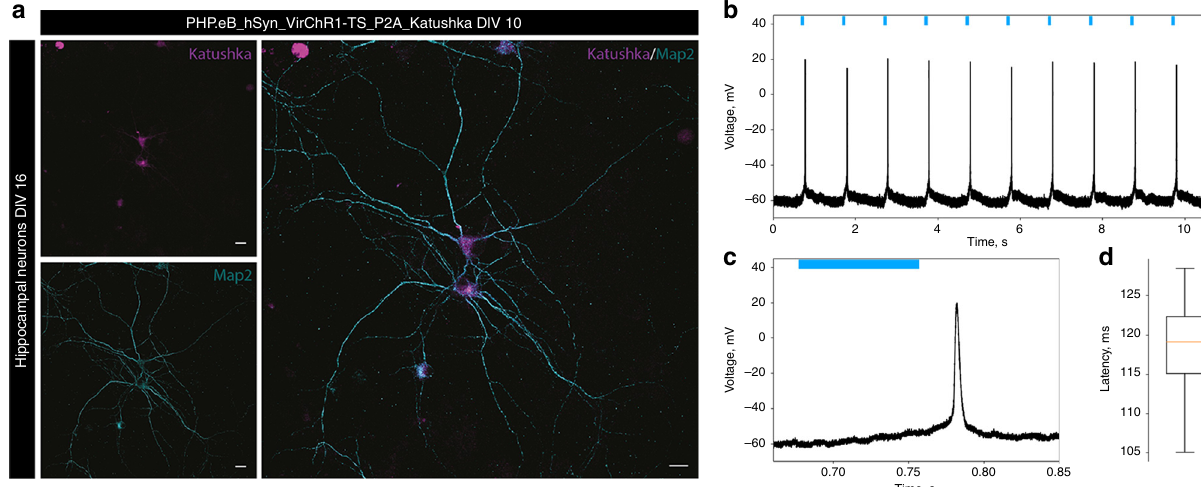
Fig. 4 Neuronal application of VirChR1 for optogenetic activation. a AAV transduction of primary hippocampal neurons at DIV10, intrinsic fl uorescence of Katushka (magenta), and neuronal marker Map2 (cyan). Scale bars 10 µ m. VirChr1 enables light-driven neuron spiking. Data presented in this fi gure refers to one representative neuron. The results showed in the microphotograph reproduced in n = 6 independent experiments. b Voltage trace showing depolarization and spikes of the neuron in response to the 1 Hz light pulse series, with 80 ms light pulses (green bars). c Expanded single spike induced by VirChR1 photoresponse. d Latencies distributions, when the neuron is illuminated with 80 ms light pulses. The box extends from lower quartile to upper quartile. The whiskers show the range of the latencies, green line is median latency, sample size, n =